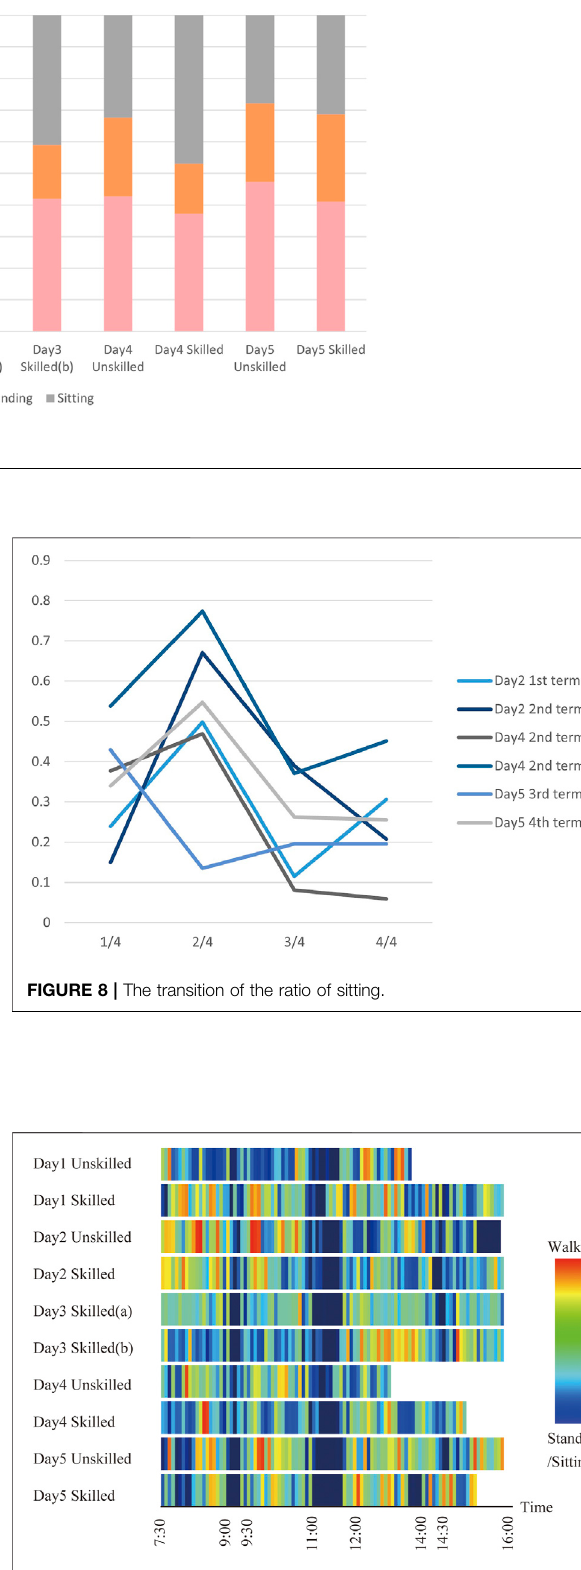
FIGURE 9 | The heat map (changes of the ratio of